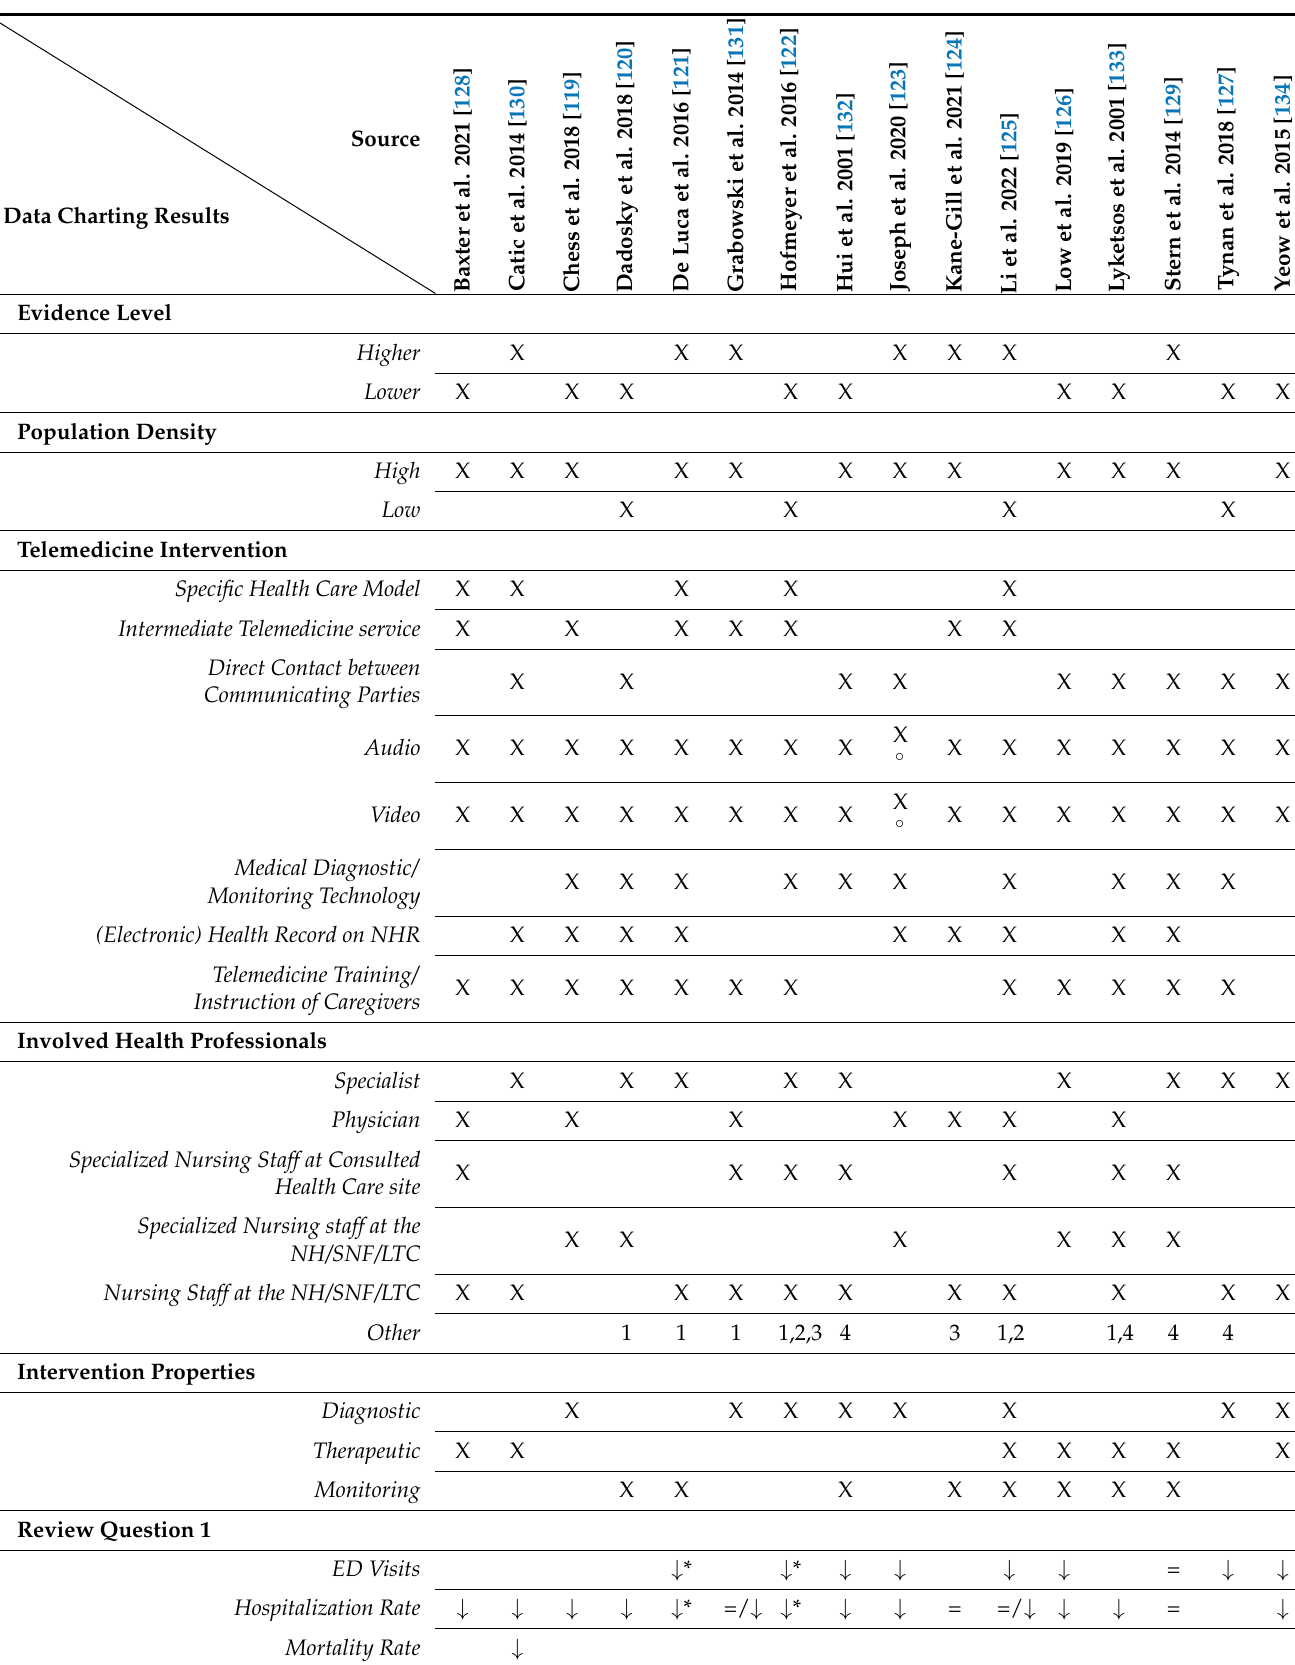
Table 2. Data charting results of comparative studies on telemedicine use and hospitalization of NHRs: identifying